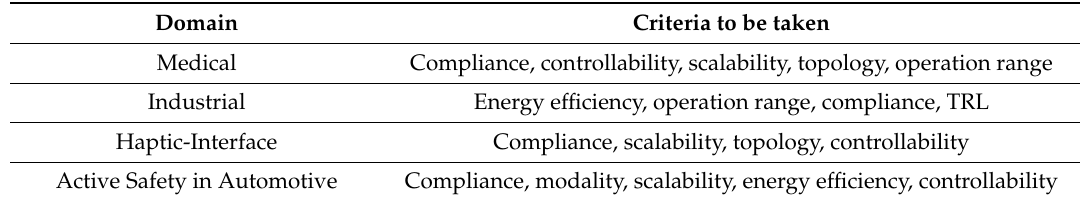
Table 6. The most important combinations of criteria sub-groups.